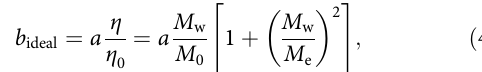
Fig. 3 Slip-inhibition on ideal substrates. a Results from PS leveling experiments (blue circles) on AF substrates. Each data point consists of 2 – 12 individual measurements and the error bars represent the standard deviation for each measurement. For comparison, results from PS dewetting experiments (orange squares, data from 48 ) on AF substrates are also shown. Two equations with one free parameter (solid lines) describe both sets of experiments: it assumes adsorption of chains in the low-shear- rate leveling experiments and no chain adsorption in the high-shear-rate dewetting experiments. b The difference in the measured slip length between leveling (blue) and dewetting (orange) experiments is con fi rmed using a different substrate (SAM) for PS (9 kg mol − 1 at 110 °C and 65